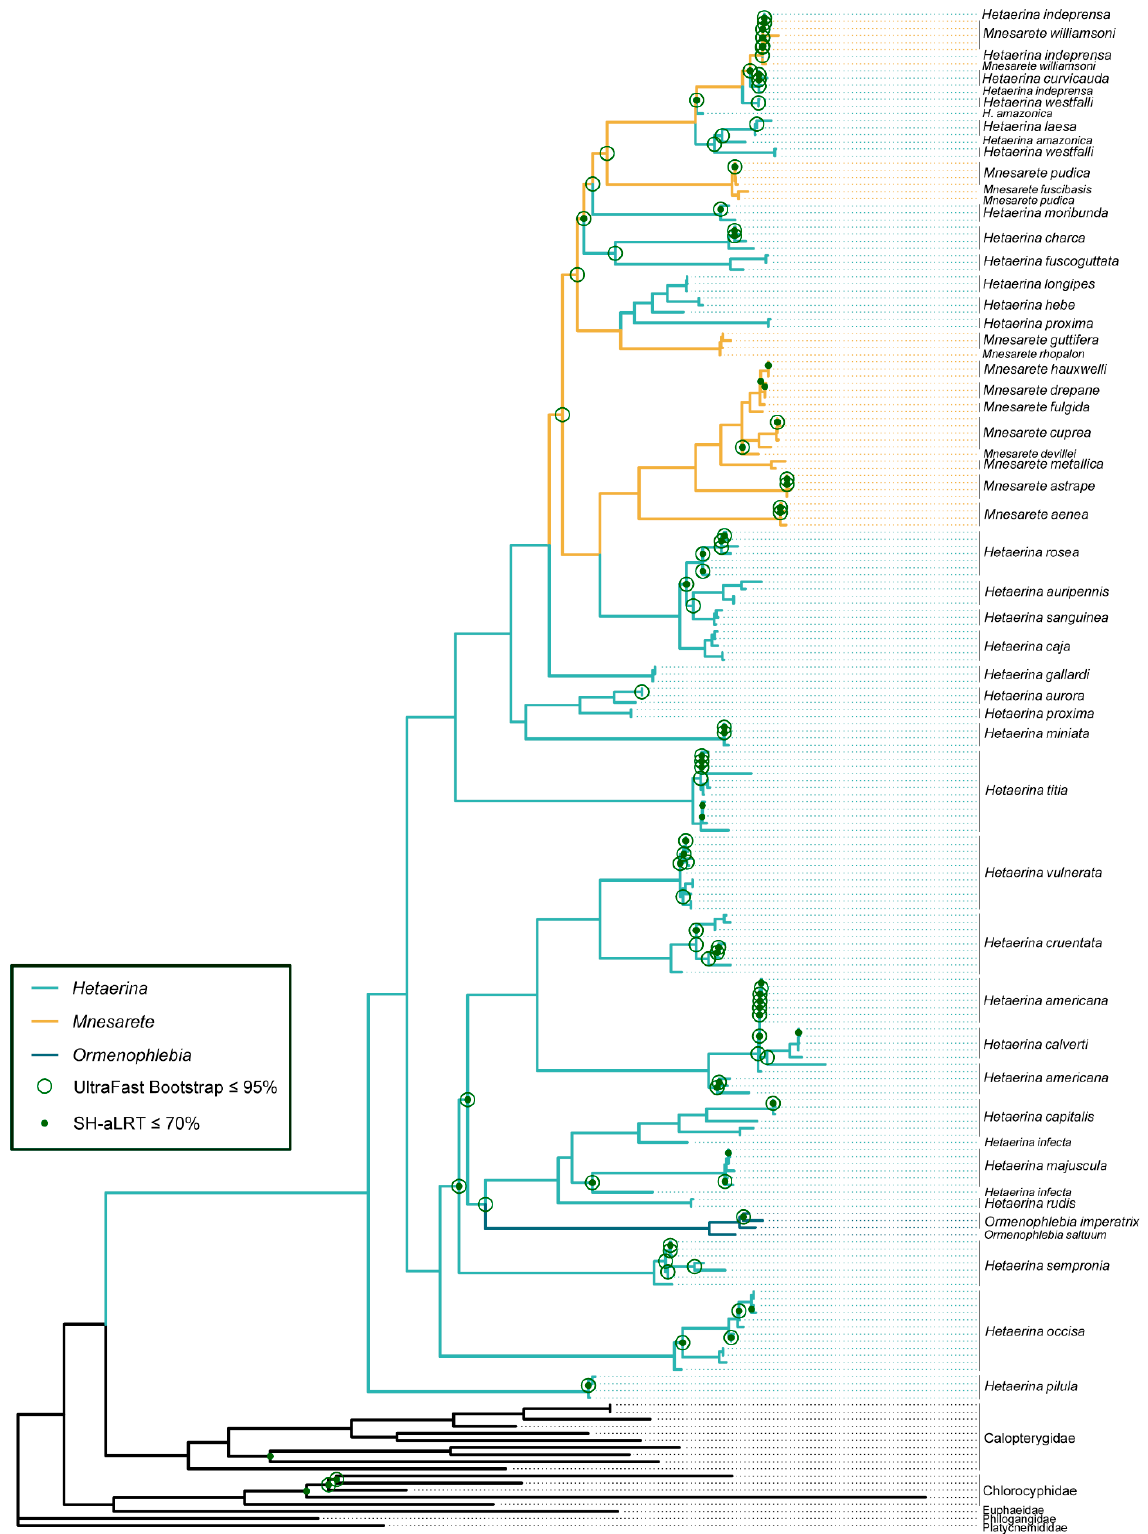
Figure 2. Maximum likelihood phylogenetic reconstruction of Hetaerininae estimated in IQtree. Relationships within and between species shown. Light blue branches: Hetaerina spp. Yellow branches: Mnesarete spp. Dark blue branches: Ormenophlebia spp. Large empty green circle: UltraFast bootstrap support less than or equal to 95%. Small filled green circle: SH-aLRT support less than or equal to 70%.